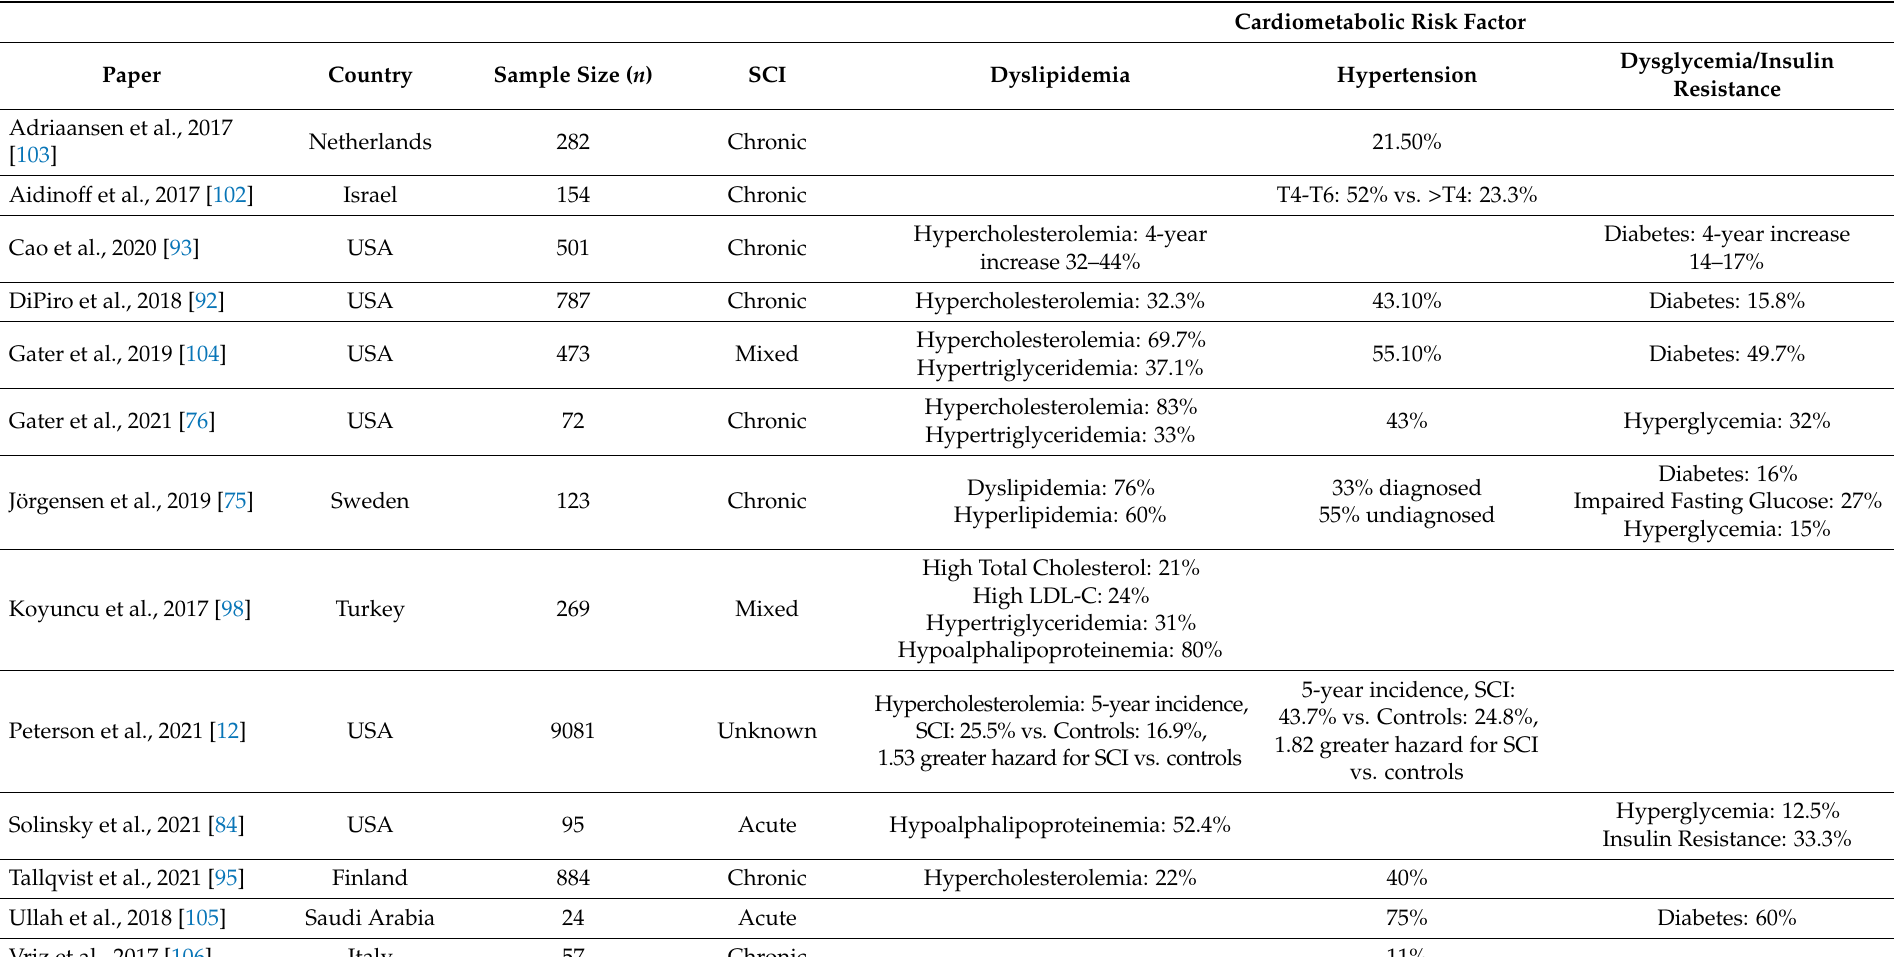
Table 4. Critical studies enumerating cardiometabolic risk after SCI over the last five